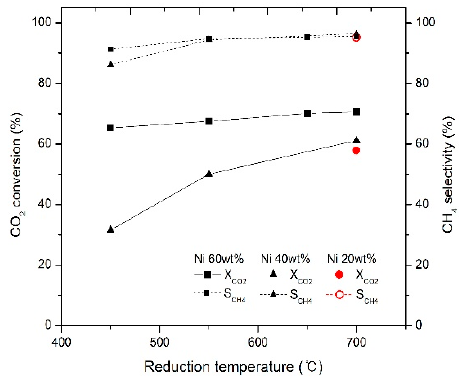
Figure 1. Effect of reduction temperature on CO 2 conversion and CH 4 selectivity at 350 ◦ C (for 20 wt%, reference [41] was